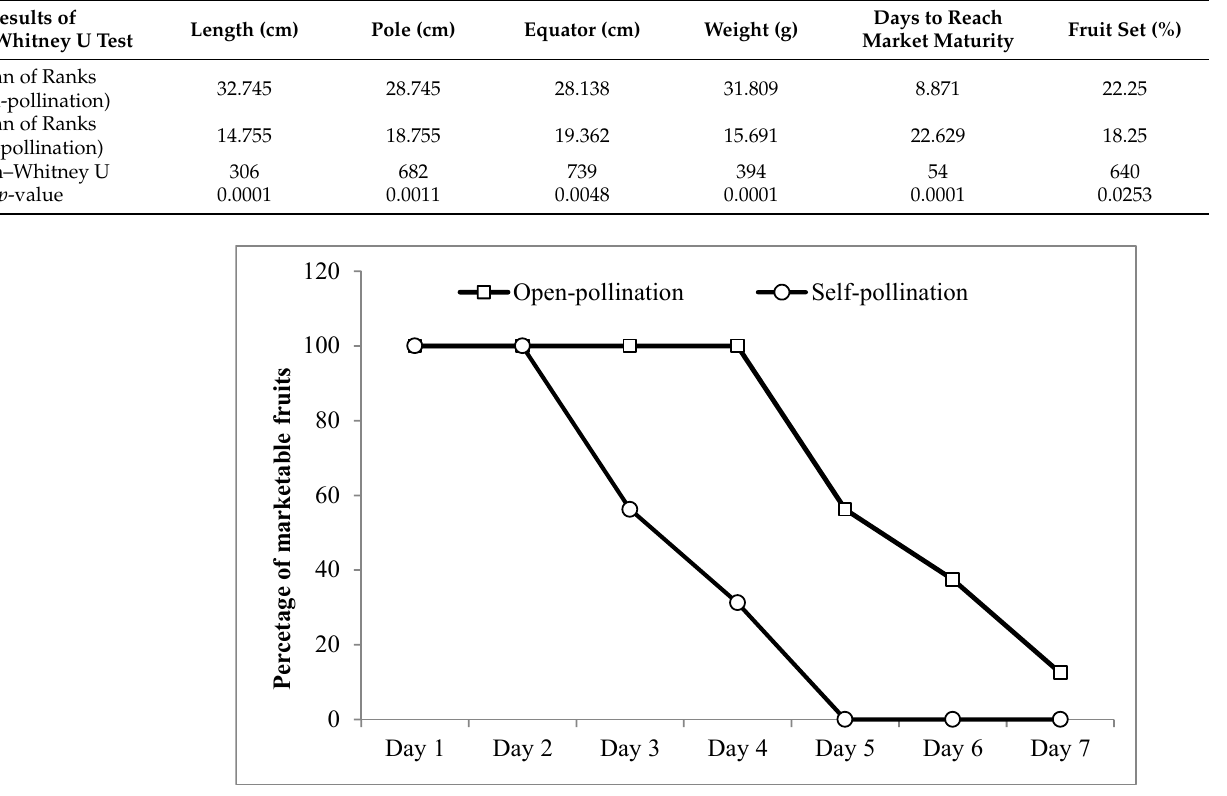
Figure 2. Percentage of marketable fruits with increasing number of days after harvesting in open ‐ and self ‐ pollinated fruits. Table 4. Comparison of mean of ranks of physical parameters of strawberry fruits between open ‐ and self ‐ pollination treatments.